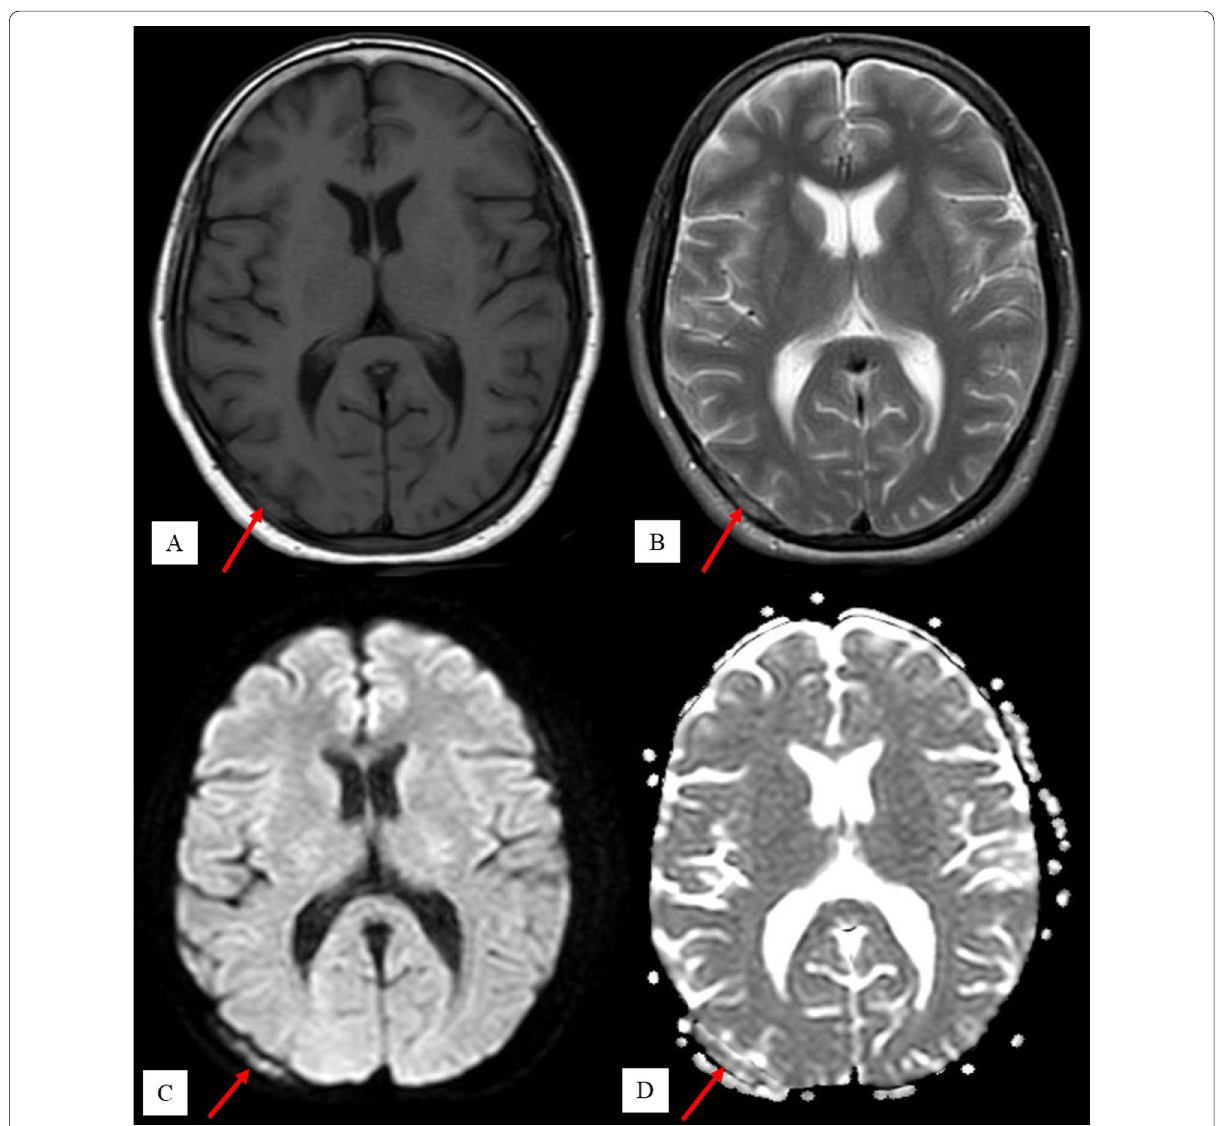
Fig. 5 Demonstration of diffusion restriction in skull lesion in 60 year old female with skull metastases from carcinoma breast- An ill defined lesion appearing hypointense on T1W ( A ) and hyperintense on T2W ( B ) images is seen in right parieto-occipital region. The lesion shows restricted diffusion appearing hyperintense on diffusion weighted image ( C ) and hypointense on ADC map ( D ). Mean ADC value was 0.636